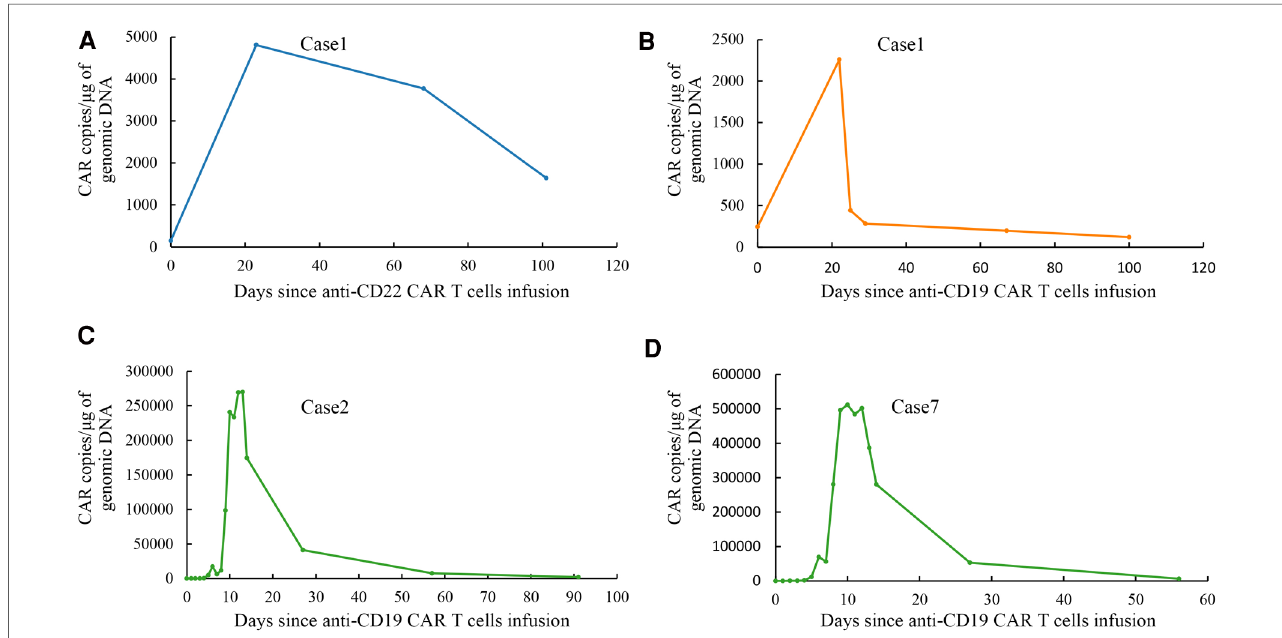
FIGURE 3 Droplet digital polymerase chain reaction analysis of CAR T cells expansion and persistence in vivo . ( A ) Expansion and persistence of anti-CD22 CAR T cells in peripheral blood of case 1. ( B ) Expansion and persistence of anti-CD19 CAR T cells in peripheral blood of case 1. ( C ) Expansion and persistence of anti-CD19 CAR T cells in peripheral blood of case 2. ( D ) Expansion and persistence of anti-CD19 CAR T cells in peripheral blood of case